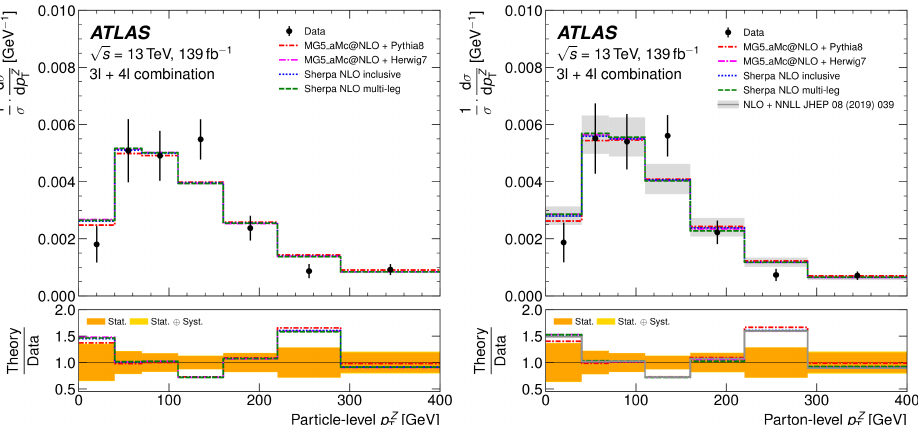
Figure 5. Comparison of normalised unfolded particle- and parton-level distribution of the transverse momentum of the Z boson in observed data from ATLAS [11] with Theoretical expectations obtained from different generators: Sherpa 2.2.1 [17] generator at NLO QCD accuracy using either multi-leg or inclusive setups and MG5_aMC@NLO [18] at NLO QCD accuracy interfaced with either the Pythia [19] or Herwig [20] parton shower